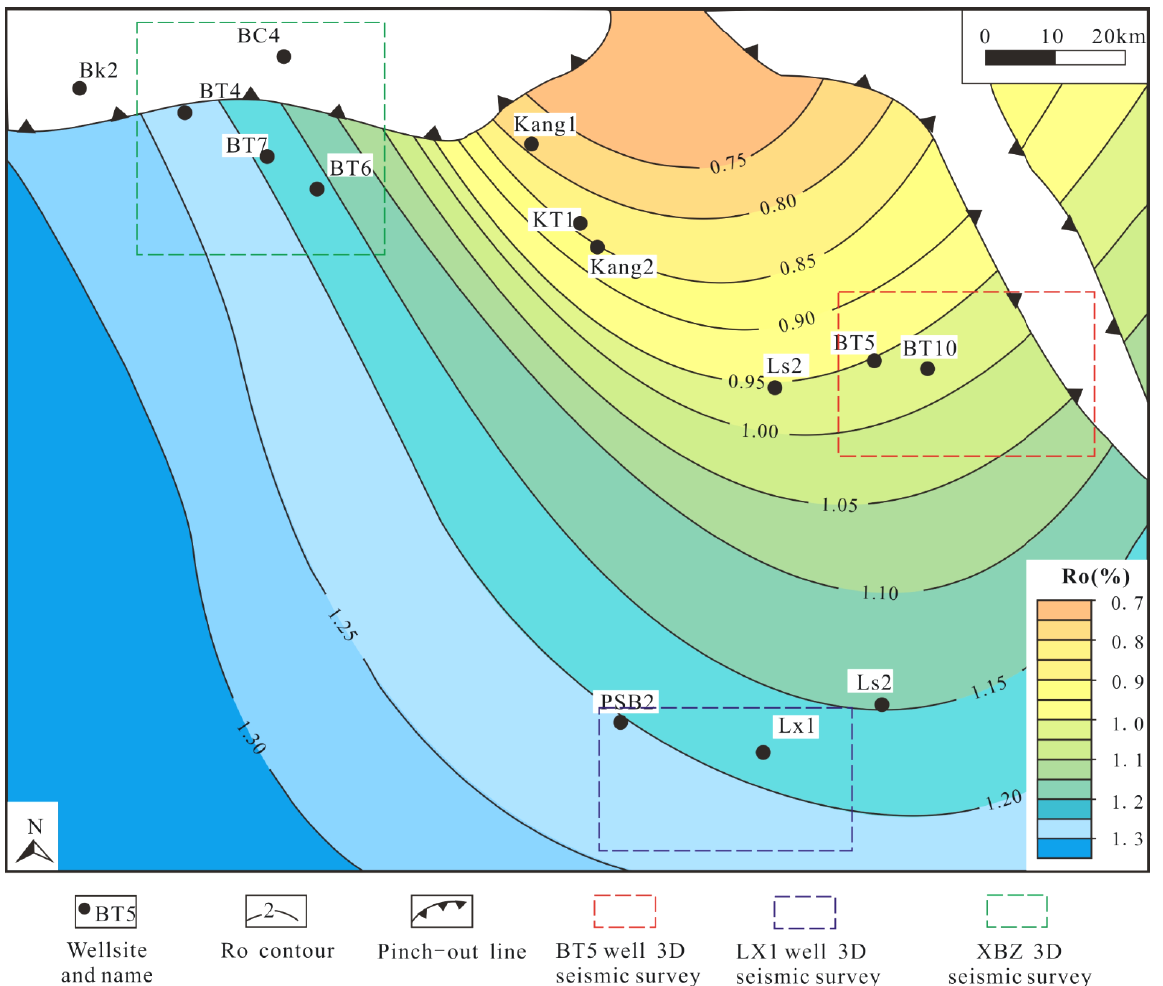
Figure 8. Vitrinite reflectance Ro contour map of the bottom Carboniferous Karashayi Formation in the Bamai area.